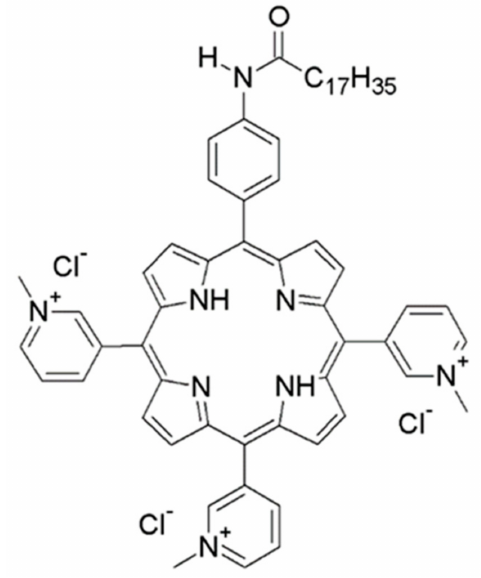
Figure 1. Chemical structure of TMPyP3-C 17 H